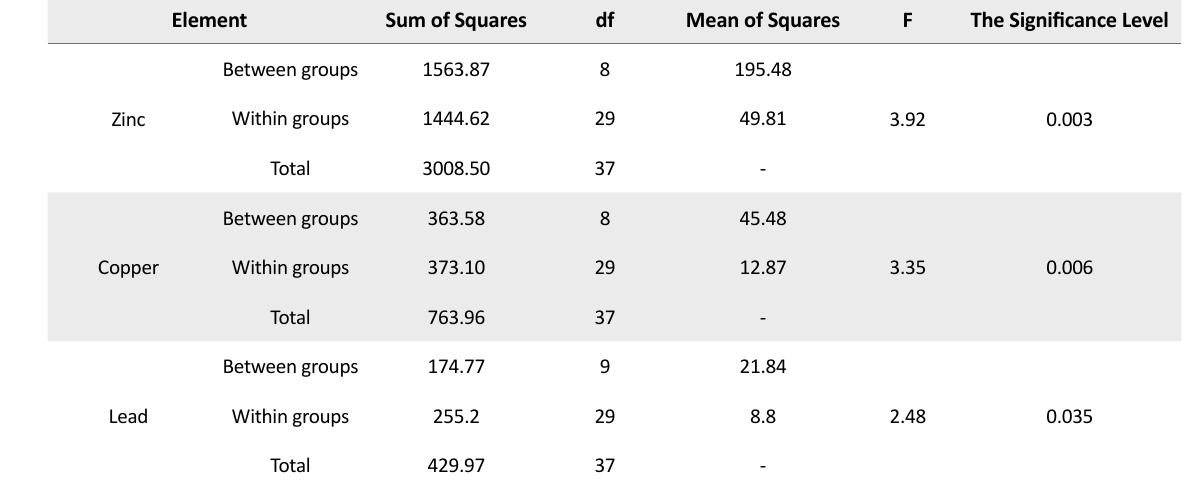
Table 7. Comparison results of heavy metal accumulation in leaves of different species using 1-way Analysis of Variance (ANOVA) at 95% significance level